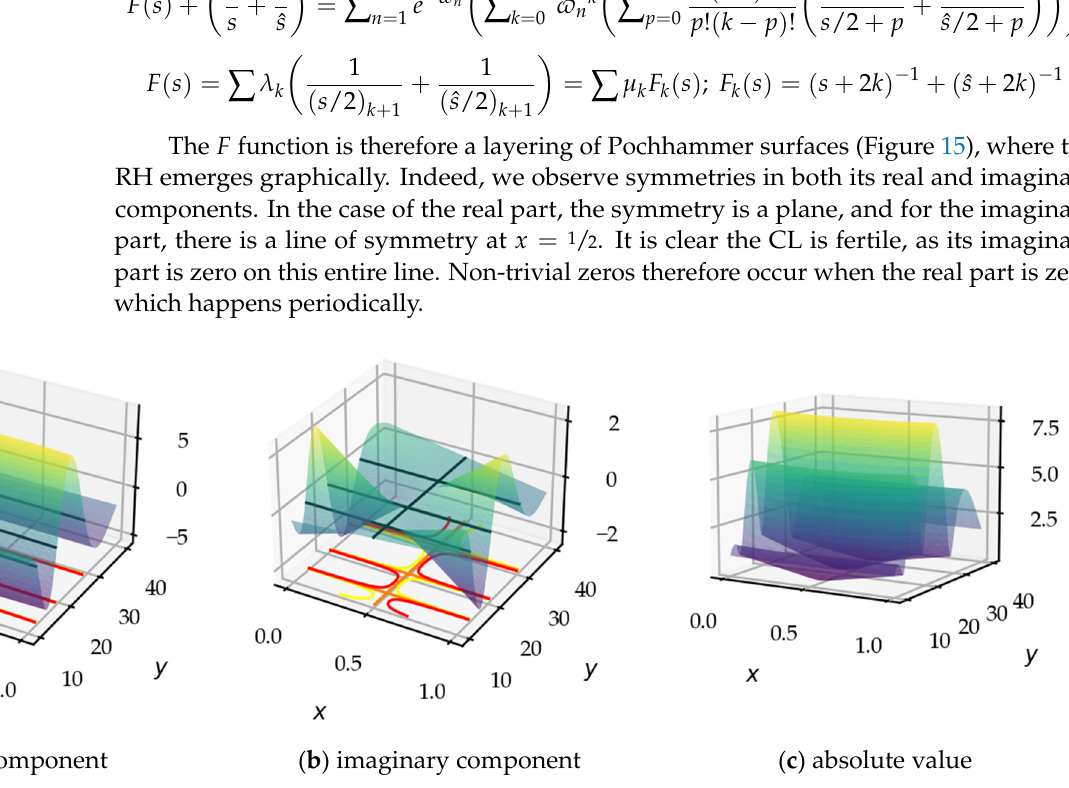
Figure 15. Pochhammer surfaces: the resemblance of the surfaces with those of Figures 3 and 7 is striking. The 𝐹 function is generated by a sum of Pochhammer surfaces.